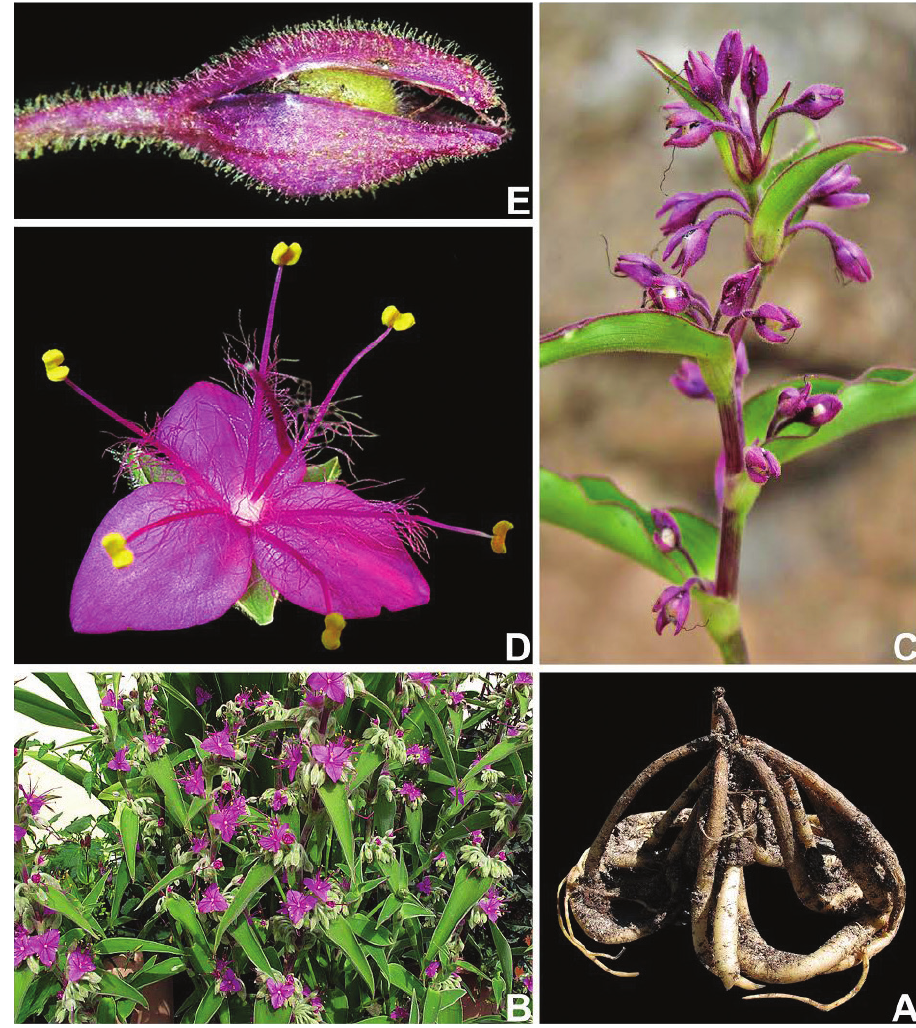
Figure 6. Tradescantia boliviana (Hassk.) J.R.Grant. A detail of the tuberous roots B habit C detail of fertile branch, showing the conduplicate leaf-blades, and axillary inflorescences D front view of a flower at anthesis, showing the rectangular connectives and C-shaped anther sacs E detail of an immature capsule, showing the densely glandular-pubescent pedicel and sepals, and the capsule apically velutine. Photograph A–B & D by P. Christian (RarePlants.co.uk), C & E by Instituto